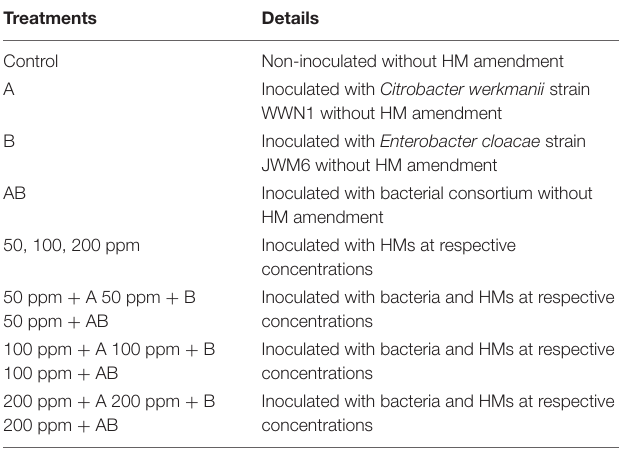
TABLE 1 | Details of the treatments used in the pot